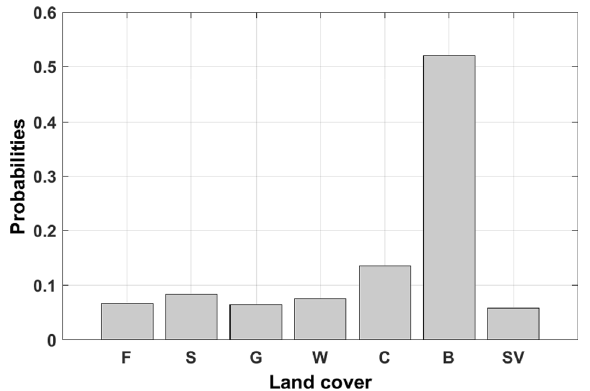
Figure 11. The statistics analysis of the FFDAS data compared with land-cover data. The horizontal axis indicates land-cover types: F-forests, S-shrublands, G-grasslands, W-water and wetlands, C-croplands, B-built-up areas and SV-sparsely vegetations.